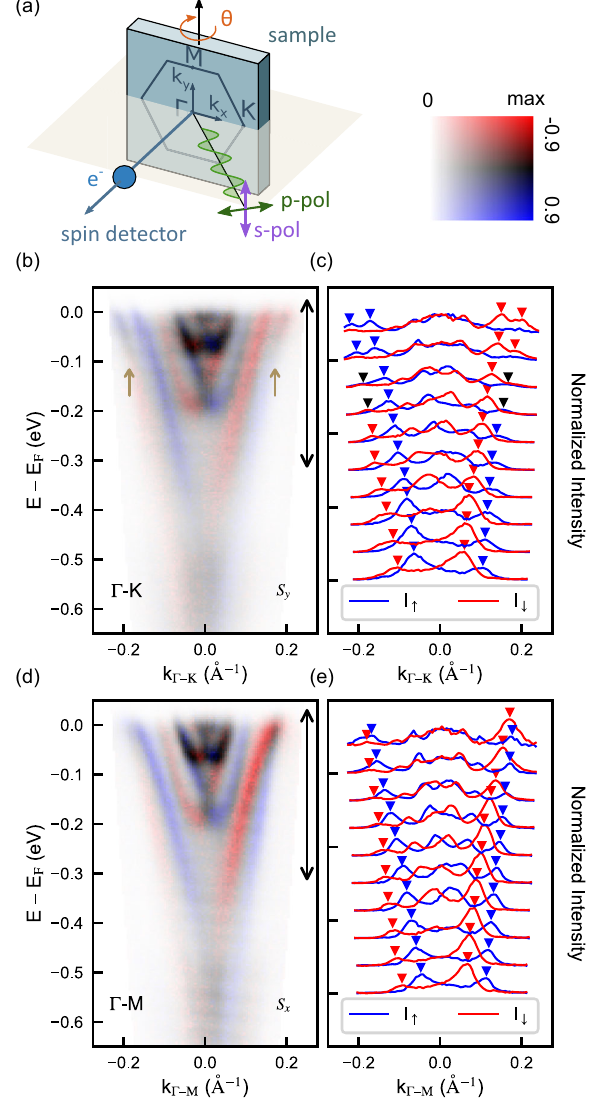
Fig. 2 Spin-resolved ARPES data on BiTeCl. a A schematic of the experimental geometry. Momentum-dependence is mapped by rotating the sample angle θ . Data in this fi gure is obtained with s - polarized light. Images are plotted with a 2D colorscale shown in the upper-right: red-blue (vertical) denotes spin-polarization and white- black (horizontal) denotes photoemission intensity. b An in-plane ( S y ) measurement along Γ -K. An unexpected reversal of the spin- polarization is seen in the outermost bands near E F (beige arrows). c The corresponding momentum distribution curves (MDCs) of spin- up I ↑ and spin-down I ↓ intensities. Each MDC is integrated within an energy window of 34 meV. Altogether, the MDCs span the energy range from − 329 to 41 meV as denoted by the double-arrows in ( b ). Each I ↑↓ pair is normalized by the maximum intensity for that pair to facilitate a comparison between MDCs at different energies. The markers are guides to the eye denoting peak positions, with blue- black-red coloring indicating the overall polarization of each peak. d , e An analogous dataset along Γ -M, in which the outermost bands merge into a single unpolarized peak near E F